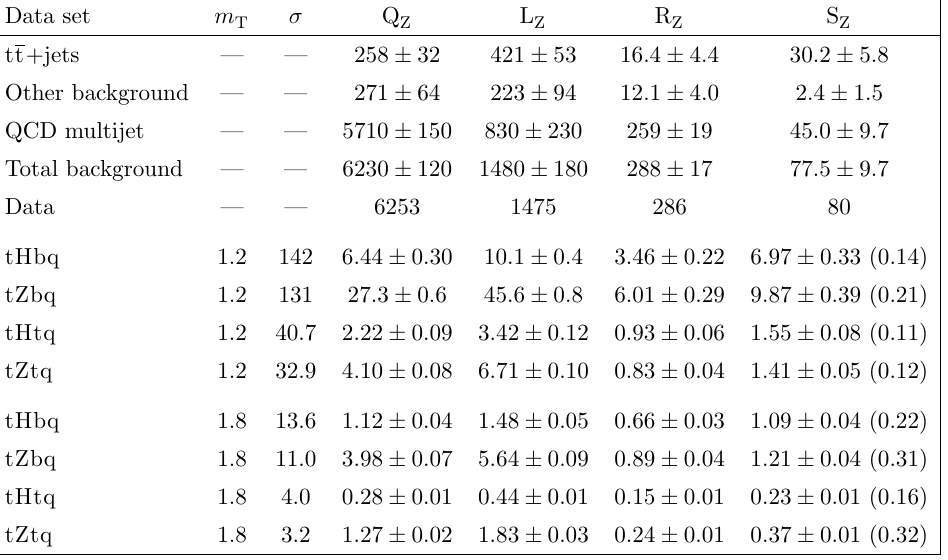
Table 5 . Post-(cid:12)t numbers of events for the Q